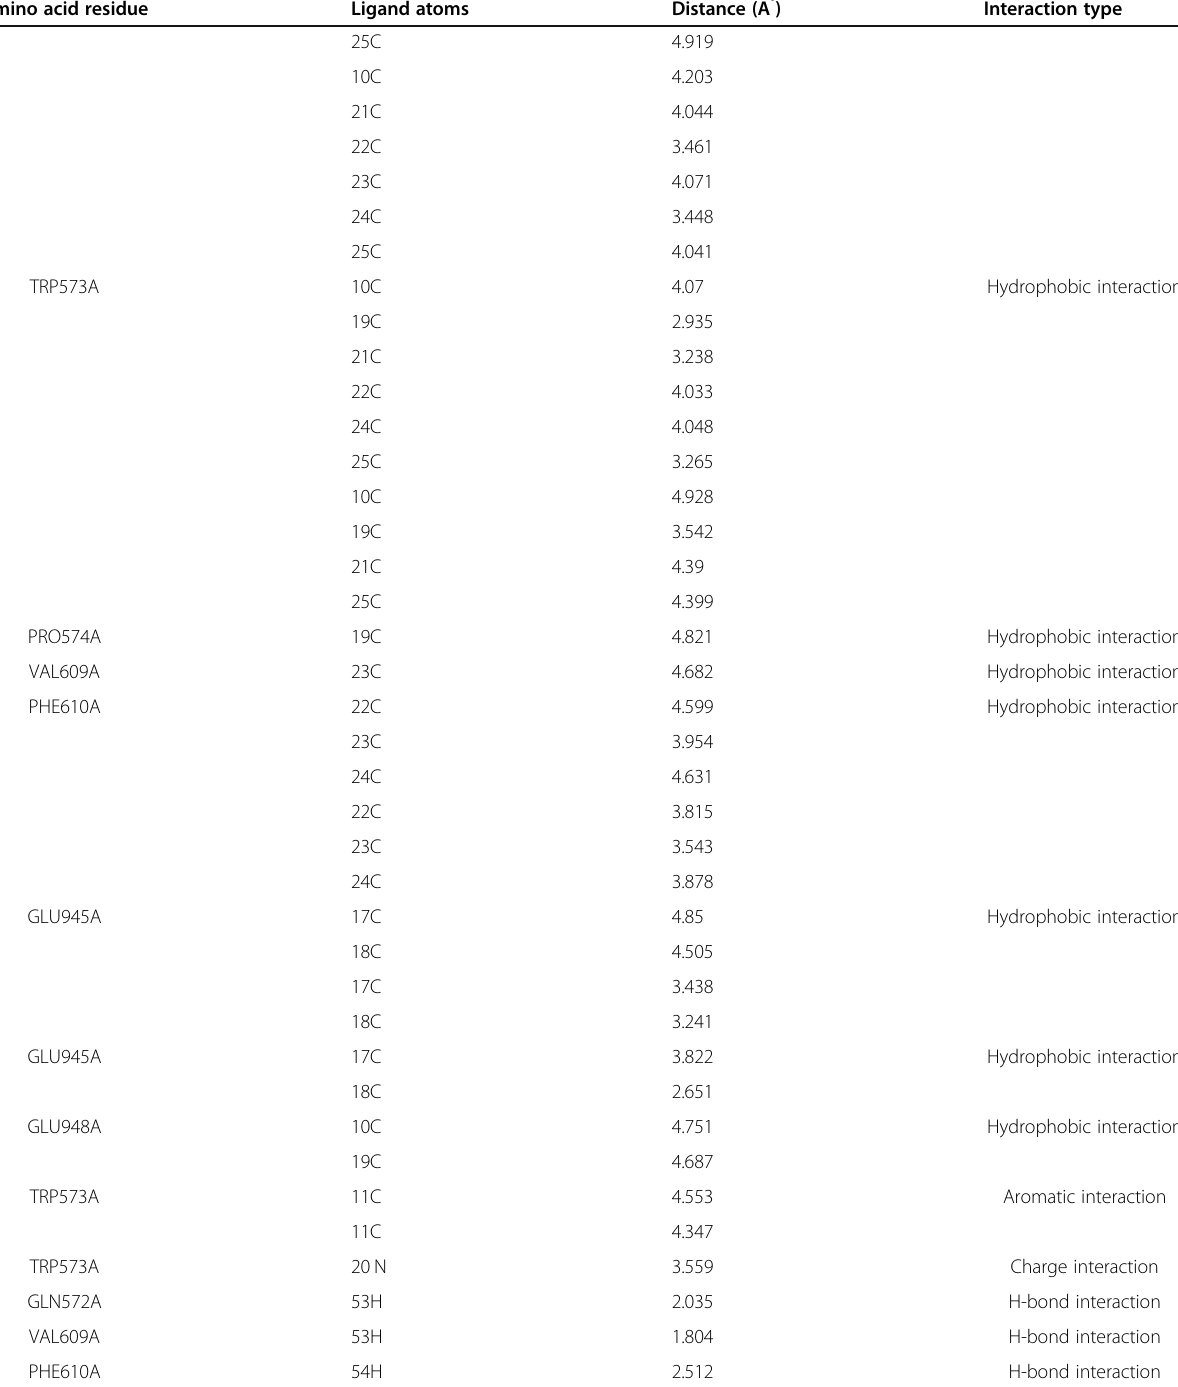
Table 5 Docking interaction of compound 51 with the binding pocket of 1S6Q (Continued) Amino acid